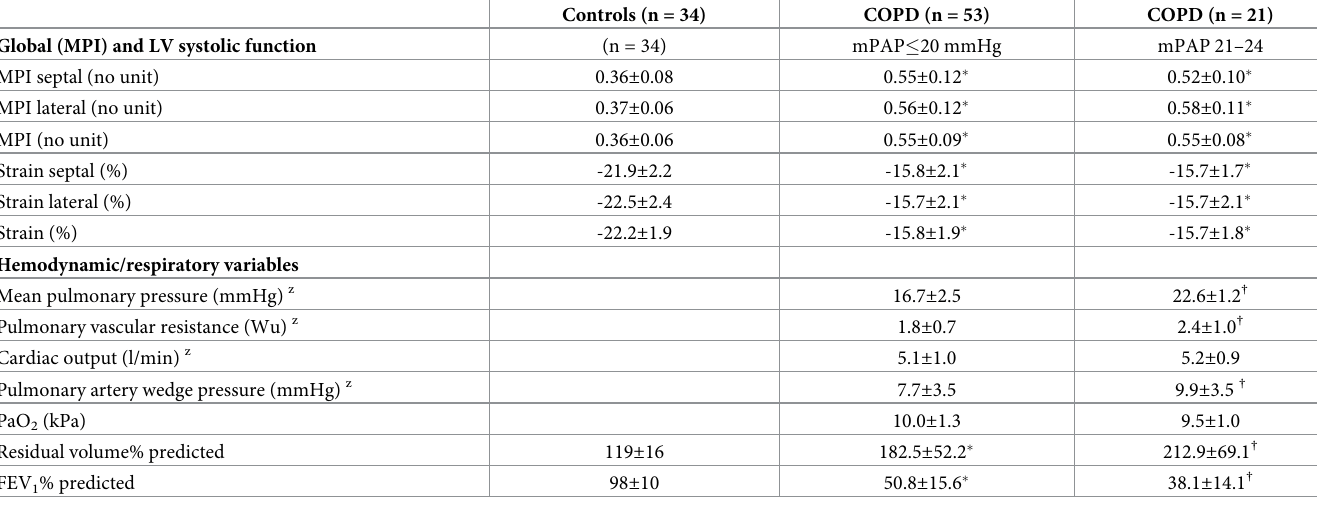
Table 4. LV function by LV MPI and LV strain, key respiratory and invasive hemodynamic indices of COPD patients with no pulmonary hypertension divided in two groups, mean pulmonary pressure � 20 mmHg (normal) and 21–24 mmHg (borderline).